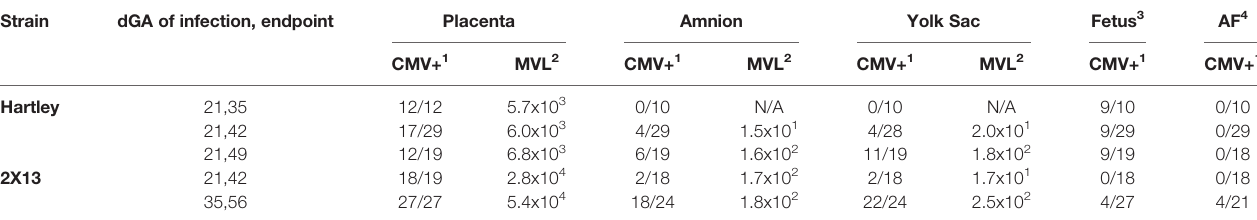
TABLE 1 | Summary of GPCMV viral load